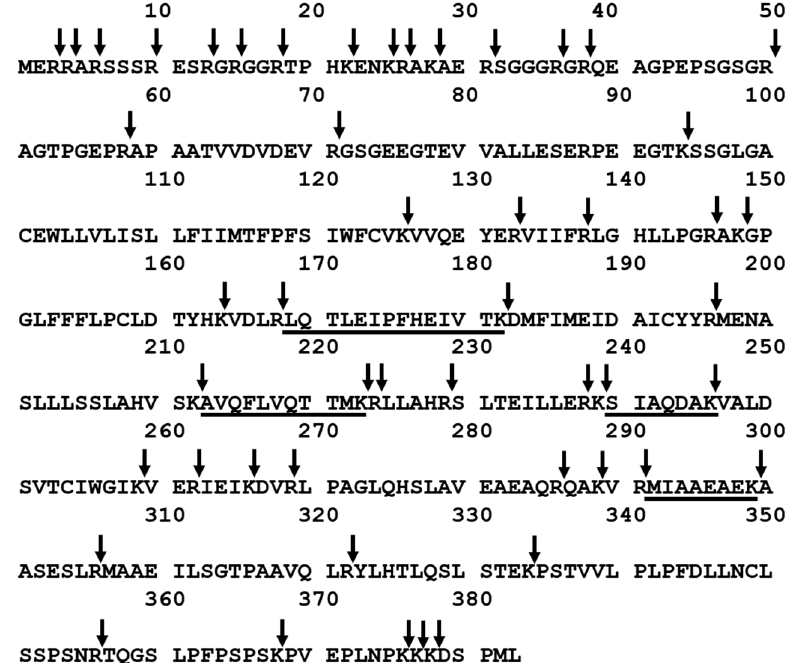
Figure 1. Sequence of human podocin with marked trypsin cleavage sites determined according to to the UniProt databases (entry name PODO_HUMAN). The selected sequences were underlined. Arrow indicates the trypsinolysis site.